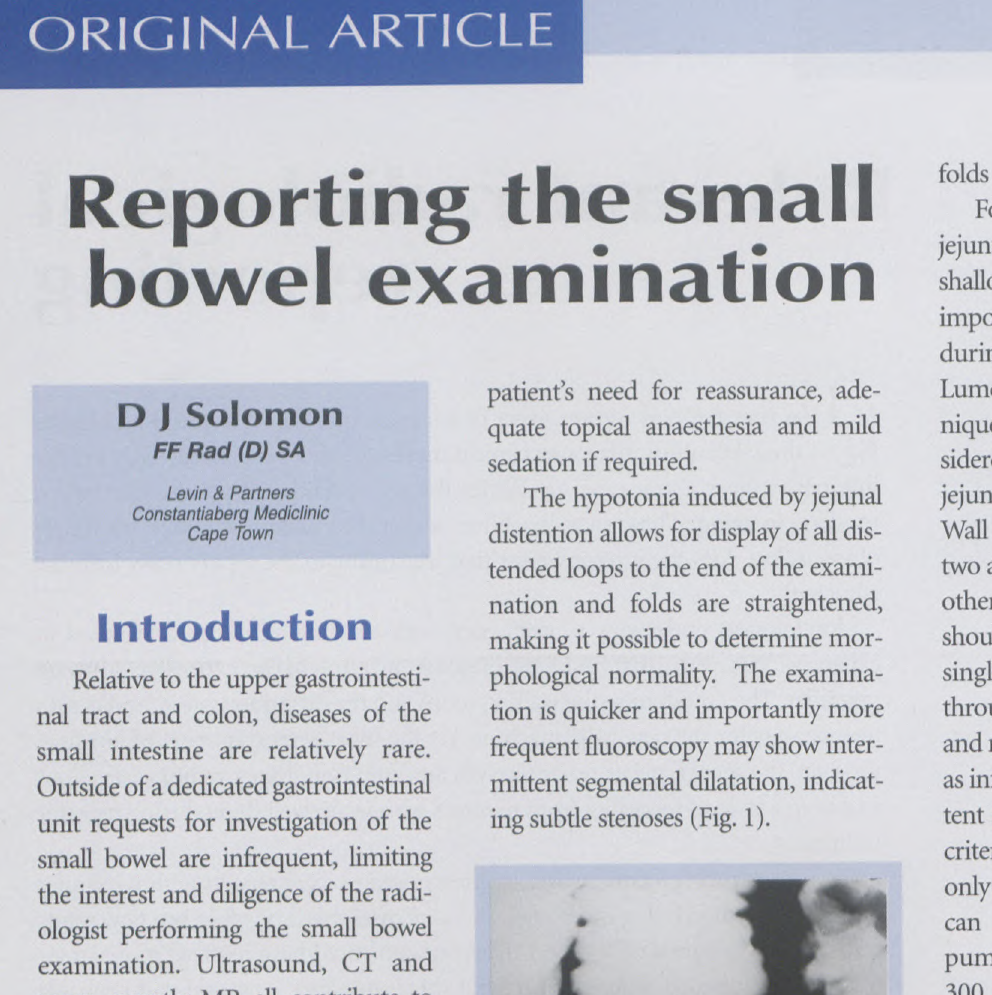
Fig. 1. Intermittent segmental dilatation in a patient with multiple stenoses due to small bowel